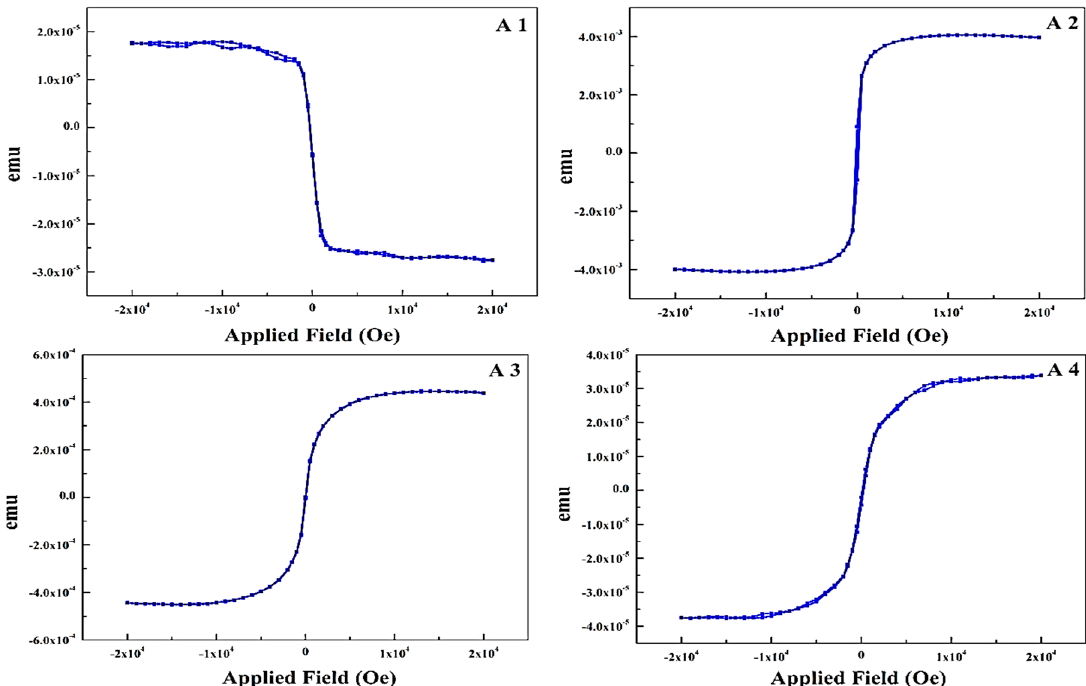
Figure 6. Magnetization measurements for the sample A1, A2, A3 and A4 respectively. ( A1 ) The hysteresis loop for the pure PET with Ag printing; ( A2 ) the hysteresis loop for pure Fe; ( A3 ) the hysteresis loop for Fe + Cu and ( A4 ) the hysteresis loop for co-sputtered Fe and Cu.